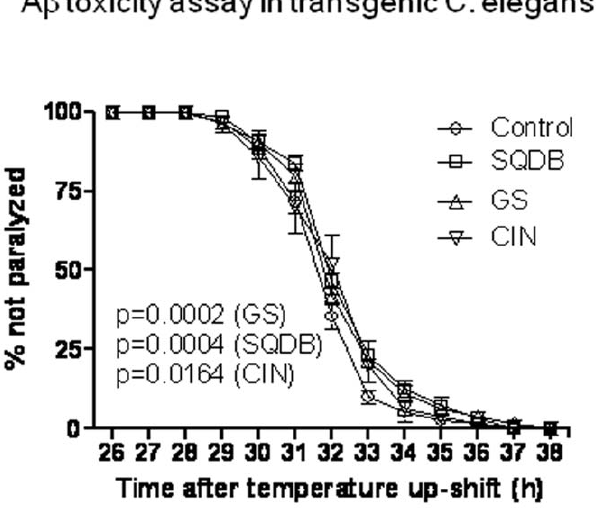
Figure 4. Paralysis assay in a transgenic C.elegans (CL4176) expressing A b . Age synchronized CL4176 worms were treated from egg until the L3 larval stage with CIN, GS (10 m g/ml) and SQDB (100 m g/ ml). The animals were allowed to cultivate at 16 u C for 38 h. At the 38 h time point, the temperature was up-shifted to 23 u C. Worms began to paralyze 25 h after the temperature up-shift and were scored at 1 hr intervals. Data are expressed as percent (%) of worms not paralyzed. SQDB, GS and CIN alleviate b amyloid-induced toxicity in the transgenic C. elegans strain.